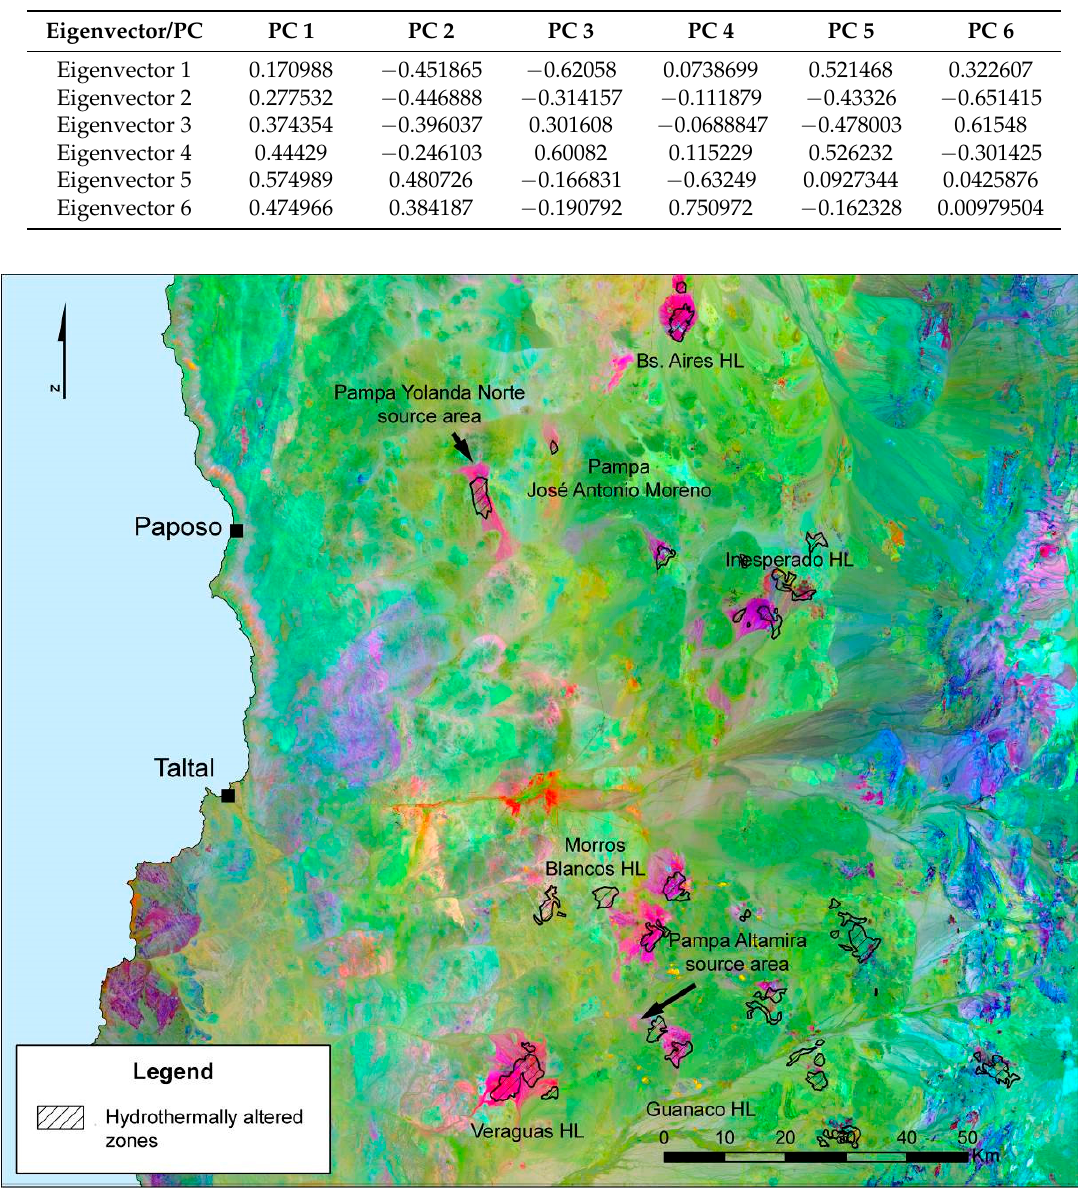
Figure 6. Landsat 8, PCs 5-4-2 (RGB) false-color composite. Potential and actual chert source areas are highlighted in magenta, and hydrothermally-altered zones are shown as black hatched polygons.